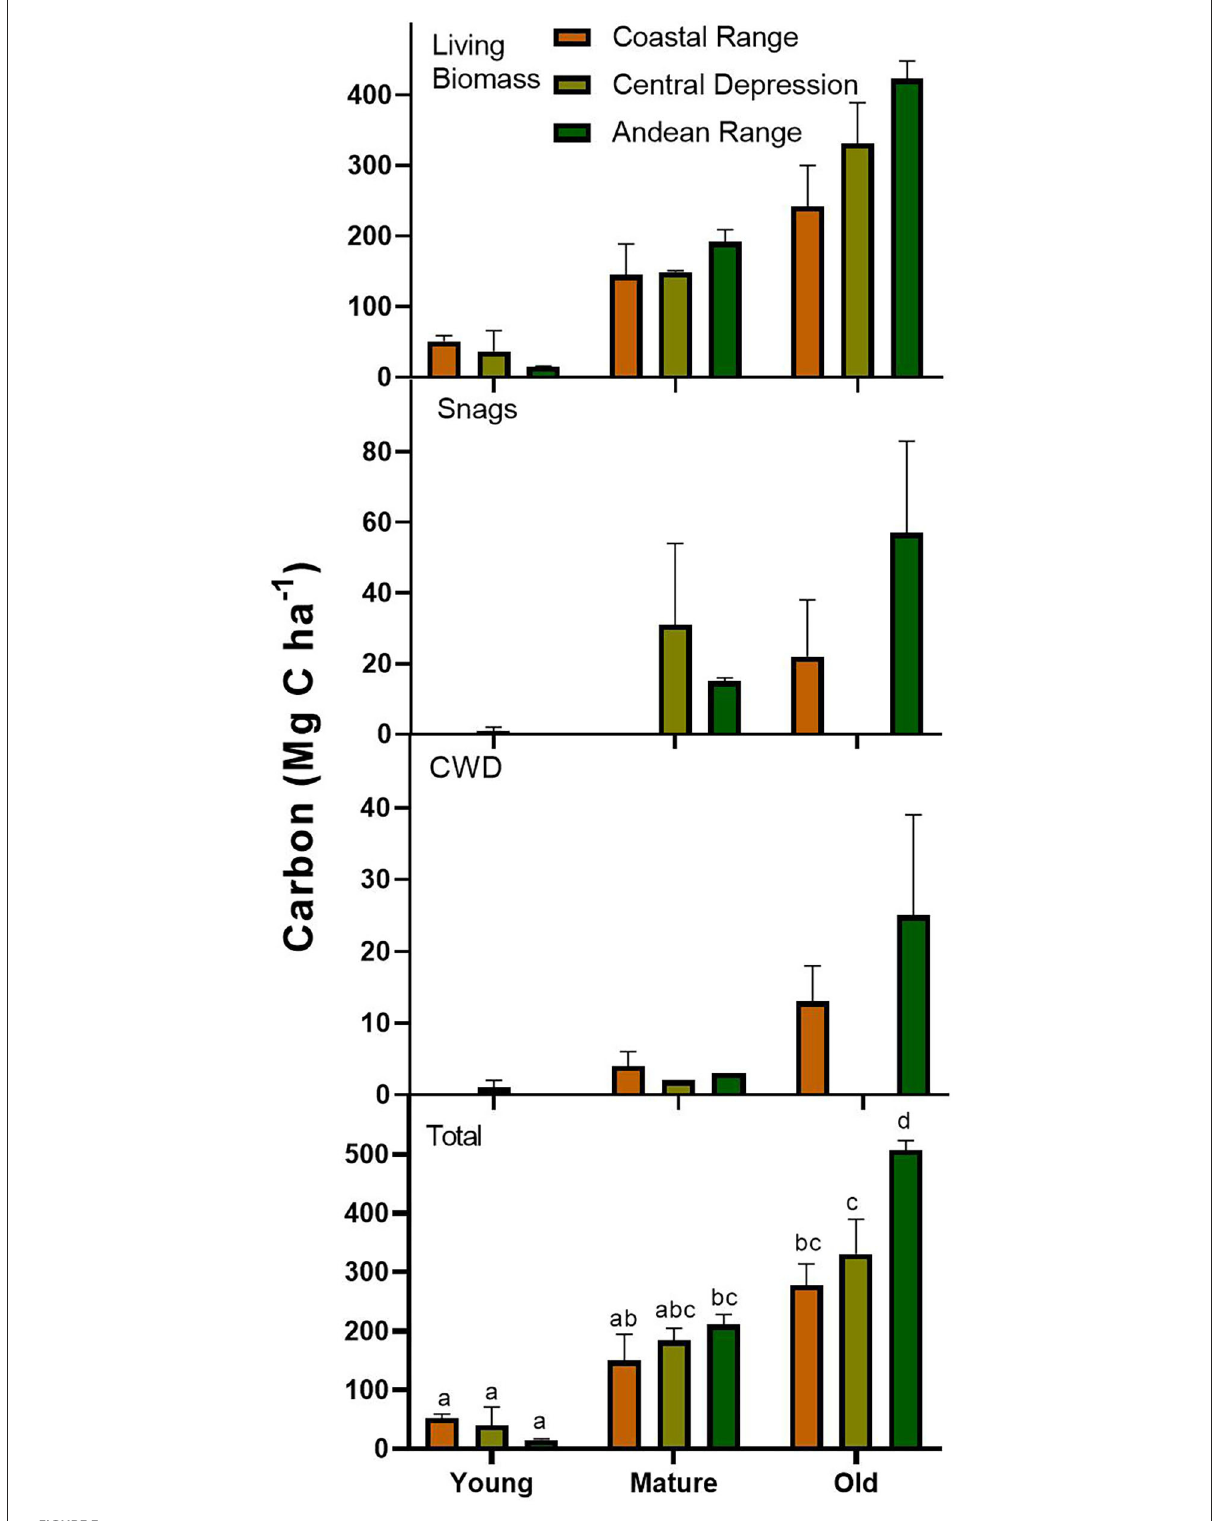
FIGURE3 Carbon stocks (Mg C ha − 1 ) in the different pools of living biomass, snags, and coarse woody debris (CWD). Total carbon aboveground is also shown for young, mature, and old-growth forest development stages across the Coastal range, Central depression, and Andean range. Bars indicate standard errors and letters in the bottom panel indicate significant differences in total C stocks among physiographic units and stages of